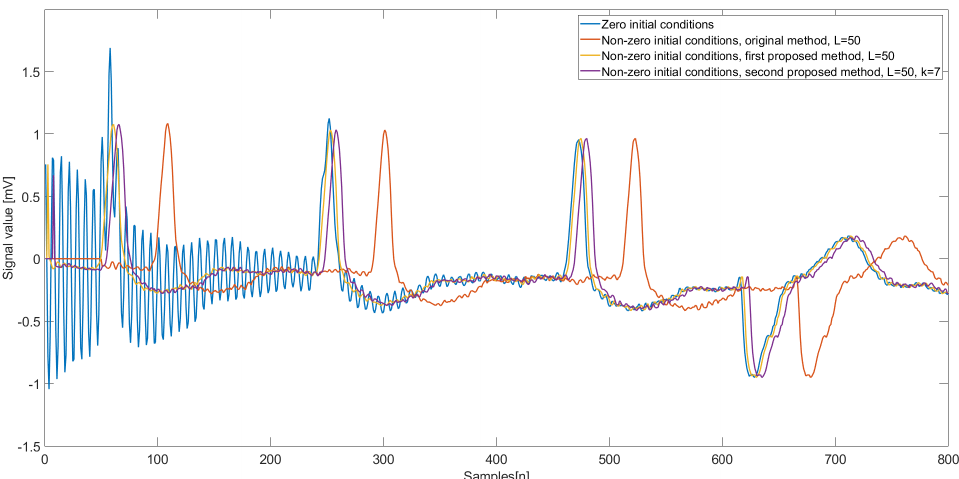
Figure 8. Results of simulation studies for ECG 1 signal. Responses of the notch filter with zero and non-zero initial conditions.